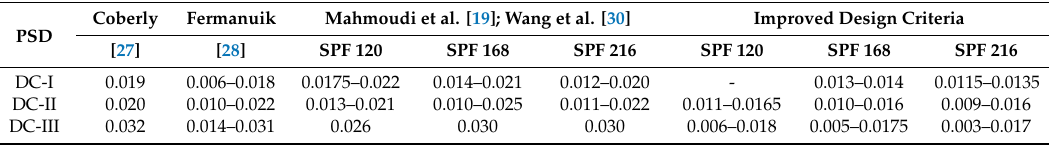
Table 6. Comparison of the slot size for DC-I, II, and III for the aggressive SAGD condition from di ff erent design criteria (all sizes are